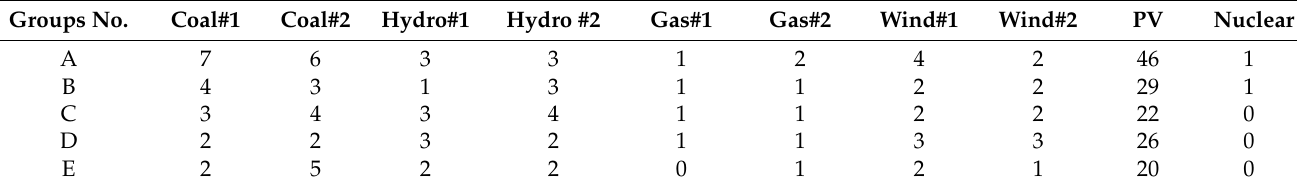
Table 1. Type and quantity of initial units owned by five power generation groups.